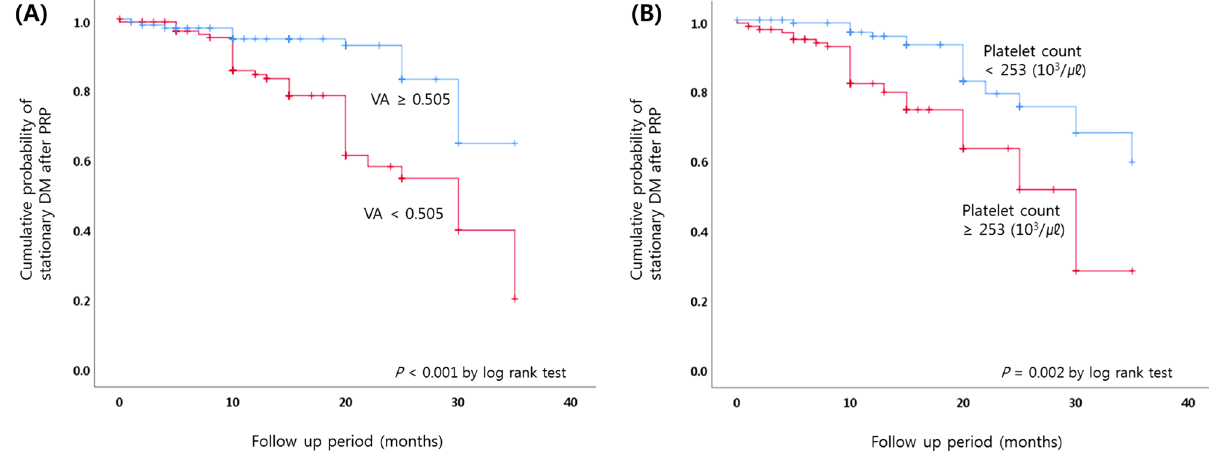
Figure 2. Kaplan–Meier survival analysis of stationary DR after PRP. The subgroups were stratified as ( A ) visual acuity (VA) < 0.505 or ≥ 0.505 and ( B ) platelet count < 253 or ≥ 253 (103/μl). Kaplan–Meier survival analysis was used to compare the cumulative probability of DR progression between the groups as stratified by the level of VA and platelet count. The VA and platelet count were classified into two groups based on the mean values for the total